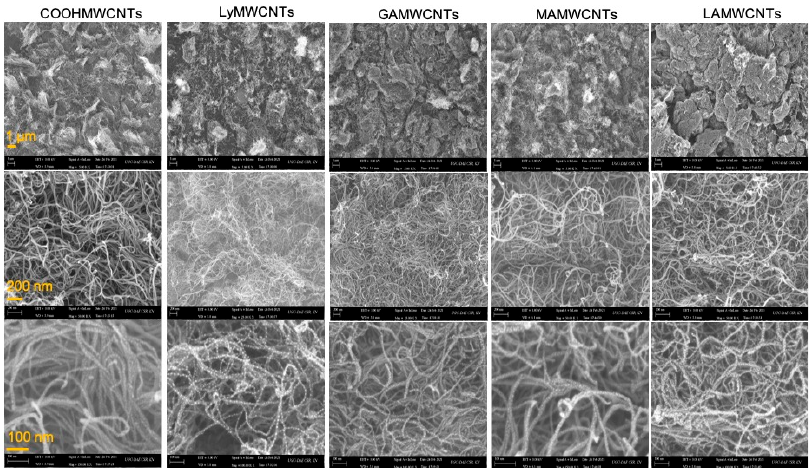
Figure 7. FE-SEM photographs of the functionalized MWCNTs in different magnifications (1 µm, 200 nm and 100 nm).